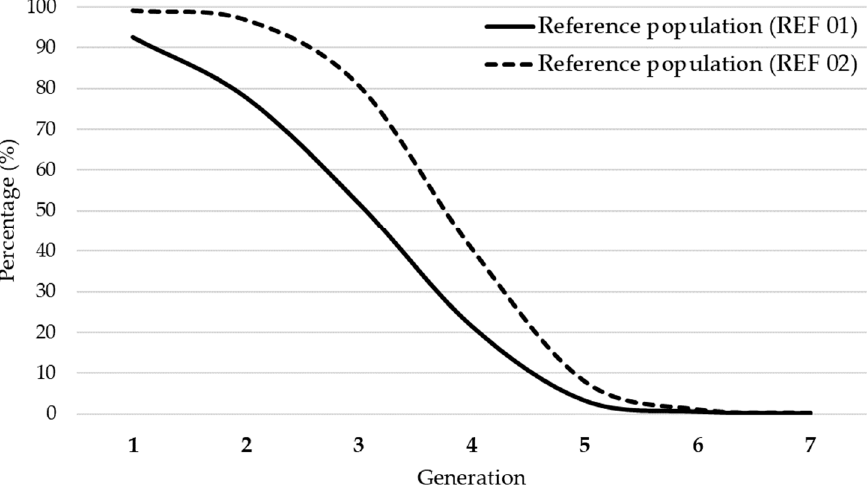
Figure 2. Average percent of pedigree completeness for the REF 01 and REF 02 reference popula-